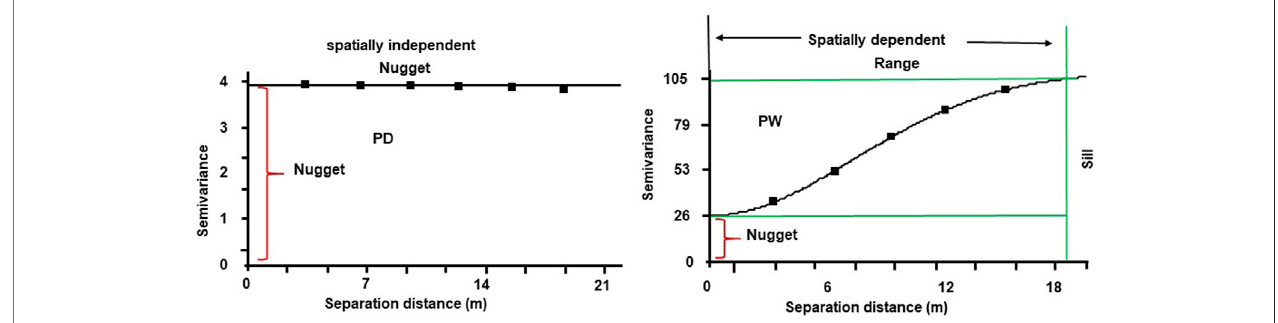
FIGURE 5 | Graphical representation of spatial variability of soil organic matter at the surface horizons of the drained (PD) and rewetted (PW) peatlands.